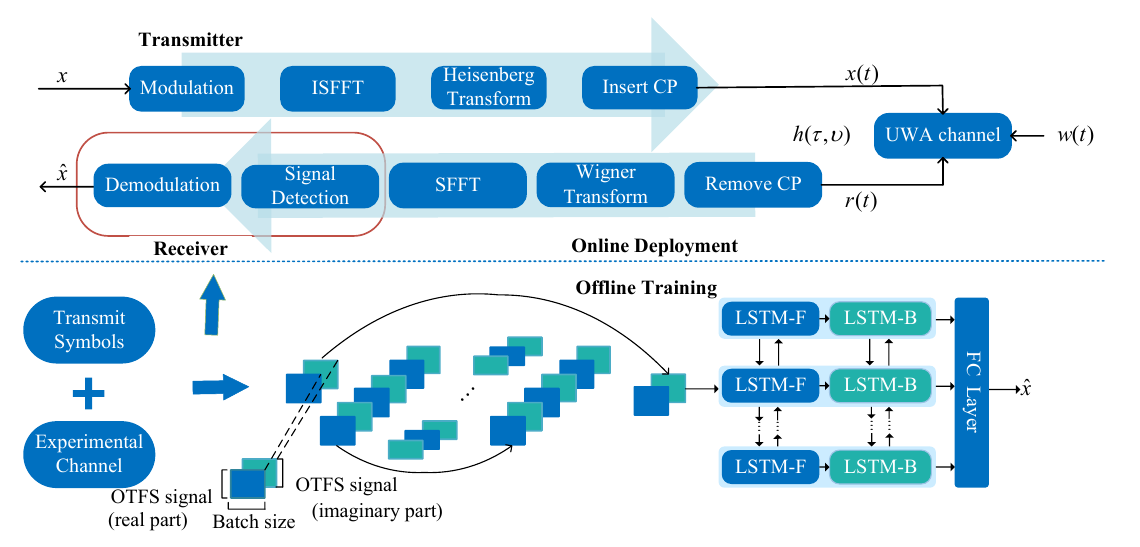
Figure 2. Deep learning-aided UWA OTFS